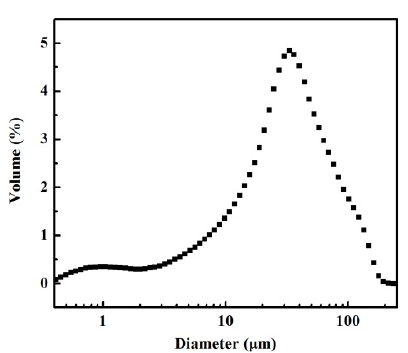
Figure 2. Particle size distribution of FEBFS samples.